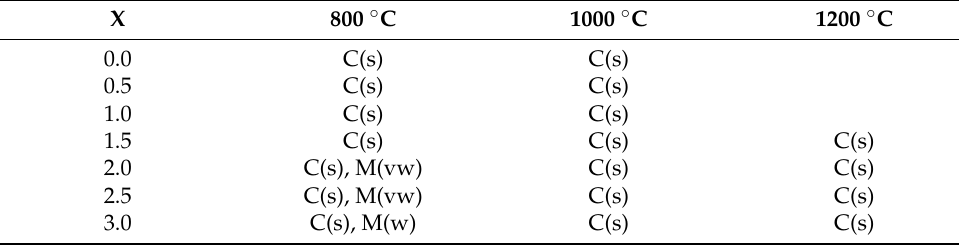
Table 1. Evolution of crystalline phases with temperature in the Mg x Co 3 − x P 2 O 8 (0.0 ≤ x ≤ 3.0) compositions. X 800 ◦ C 1000 ◦